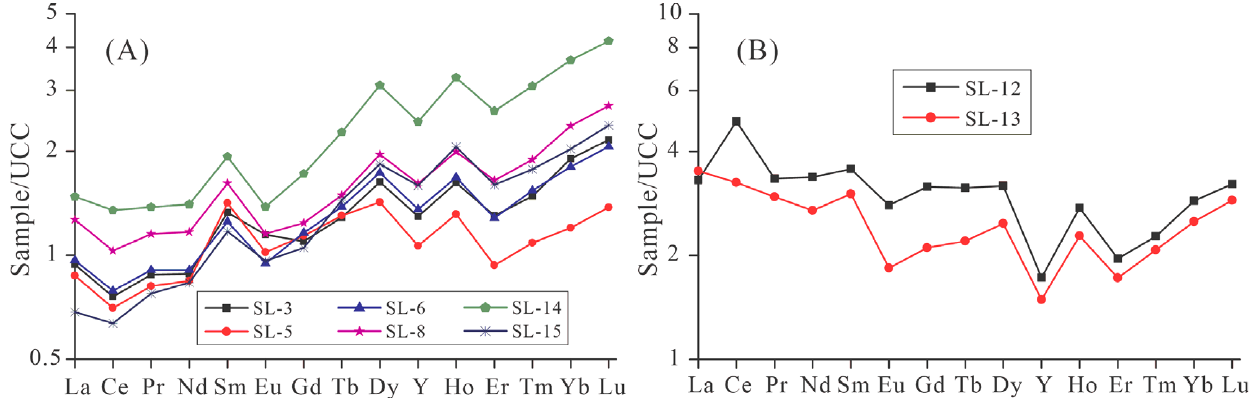
Figure 10. UCC-normalized REY distribution patterns in the studied samples ( A , B ). UCC data from Taylor and McLennan [22].